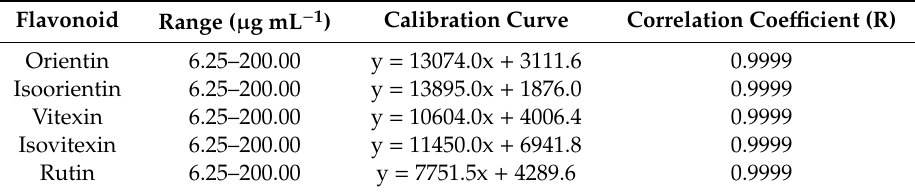
Table 2. Calibration curves constructed from standard flavonoid solutions.